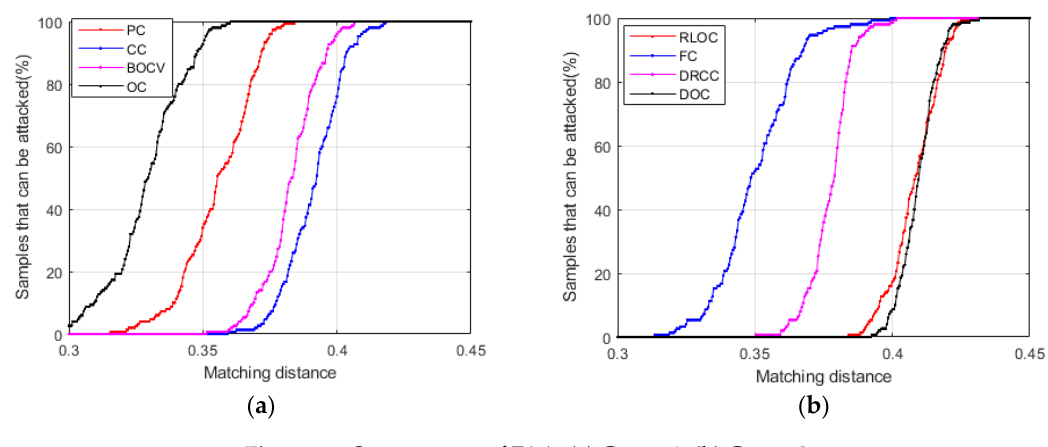
Figure 12. Success rates of FAA. ( a ) Group 1; ( b ) Group 2